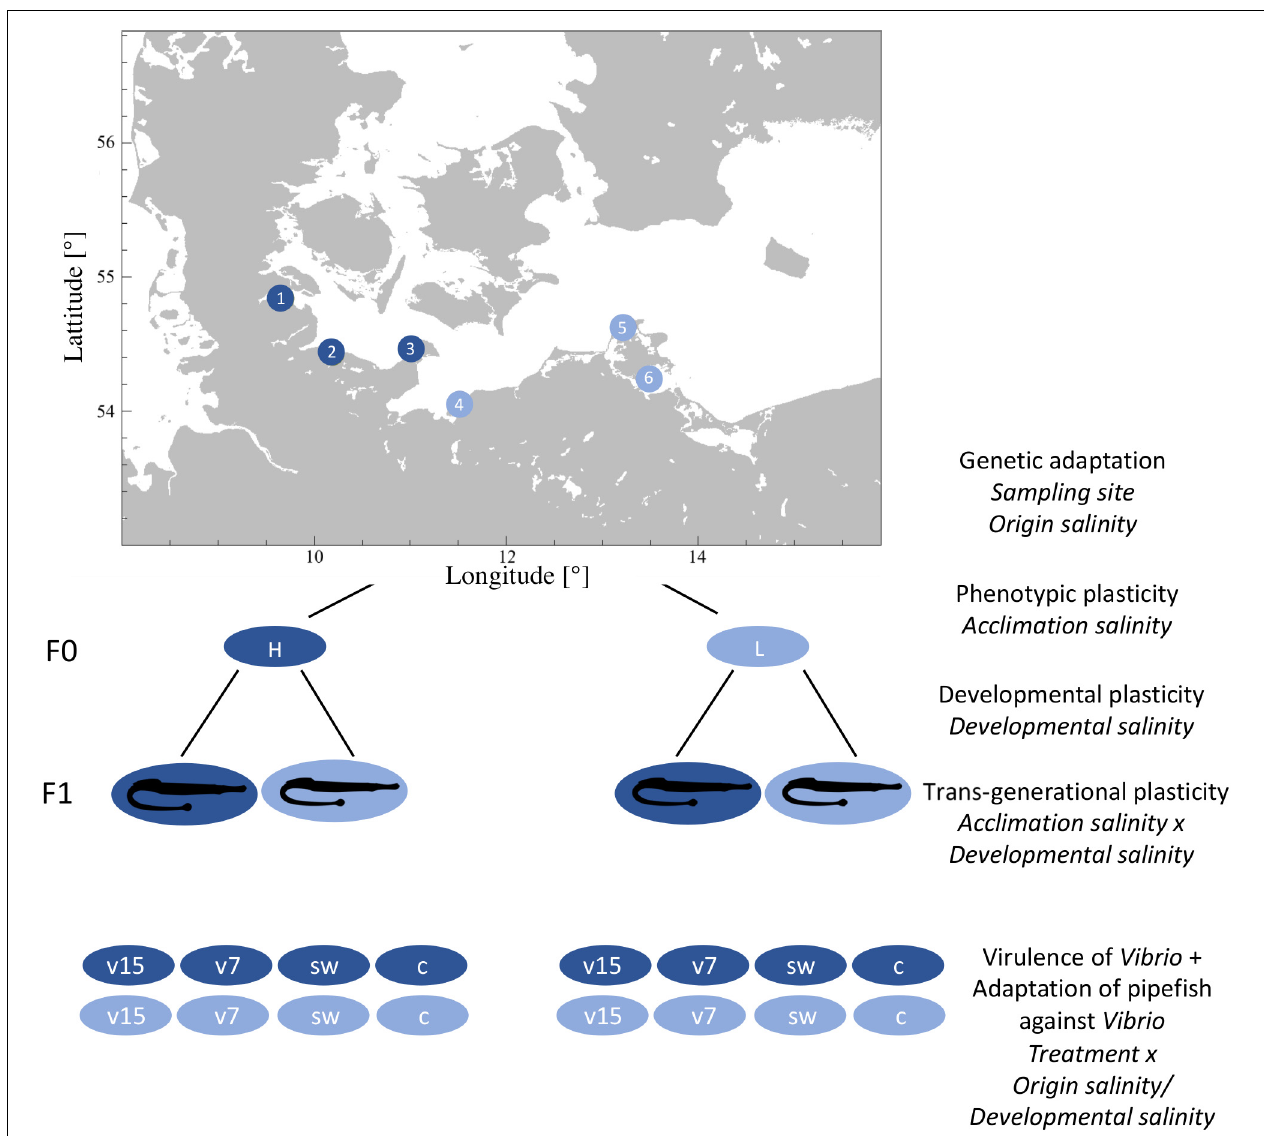
FIGURE 1 | Fully reciprocal experimental design. We sampled pipefish along the Baltic Sea coast, at three sampling sites from a relatively high saline environment (high origin salinity : 14–17 PSU; dark blue circles; subsequently labeled as italic H ): (1) Flensburg Fjord, (2) Falckenstein Strand and (3) Fehmarn and three sampling sites with a relatively low salinity level (low origin salinity : 7–11 PSU; light blue circles; subsequently labeled as italic L ): (4) the Salzhaff and (5) Ruegen North and (6) Ruegen South. In the laboratory males and females were kept separately and acclimated to the opposing salinity [ acclimation salinity : 15 PSU (H, dark blue), 7 PSU (L, light blue)] or their respective native salinity. Subsequently, males and females were allowed to mate and pregnant males were kept at constant conditions. Half of the F1 generation was either exposed to high (h) or low (l) salinity within 24 h after birth ( developmental salinity ). Ten days post hatch juveniles were injected with Vibrio alginolyticus evolved at 15 PSU (v15) or at 7 PSU (v7), sham injected with sterile seawater (sw) or left naive (c) ( treatment ). Label in italic on the right side correspond to the factors that were considered in the statistical models.